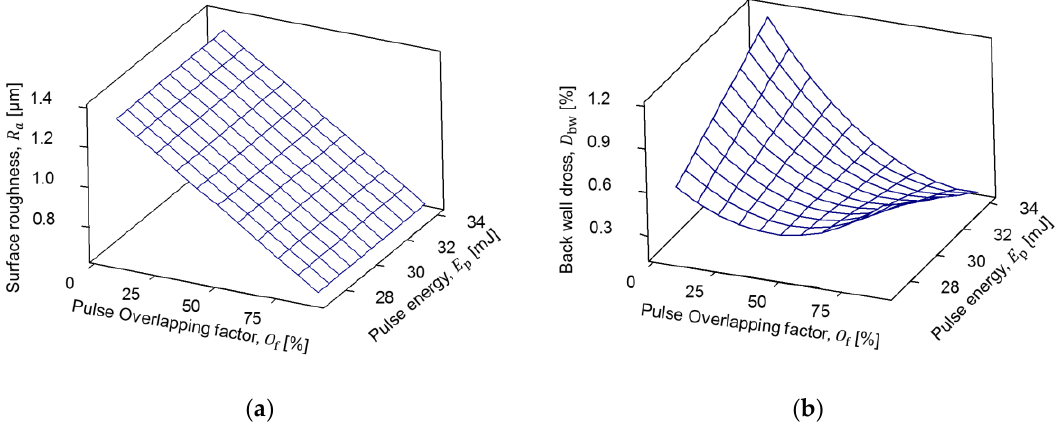
Figure 7. Results for Tube B (1.8 mm outside diameter and 0.16 mm thickness): ( a ) average surface roughness response; ( b ) back-wall dross response.